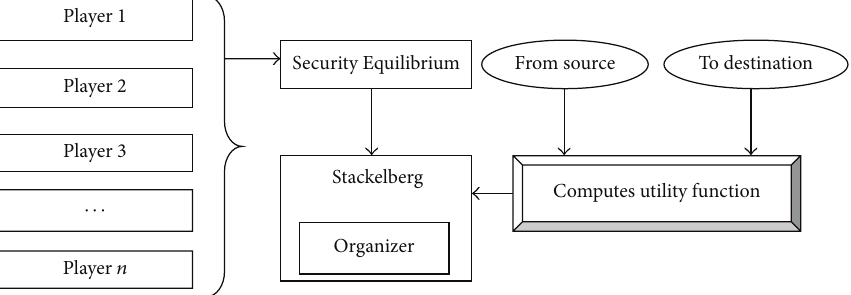
Figure 3: Process of Stackelberg Security